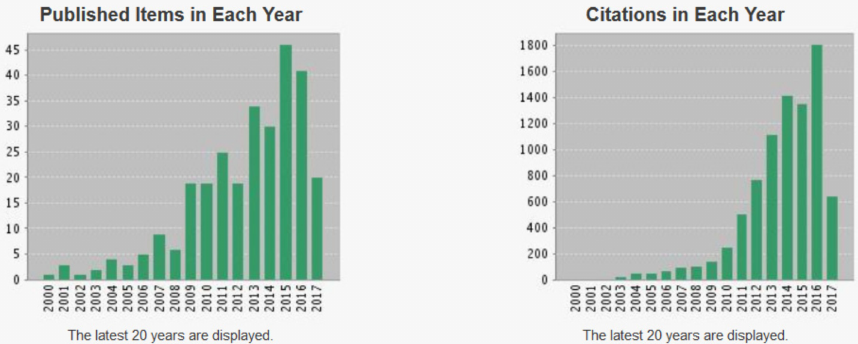
Figure 9. The increasing trend of Au applicability in photocatalysis (Web of Knowledge, https://apps. webofknowledge.com, access date: 22 May 2017).